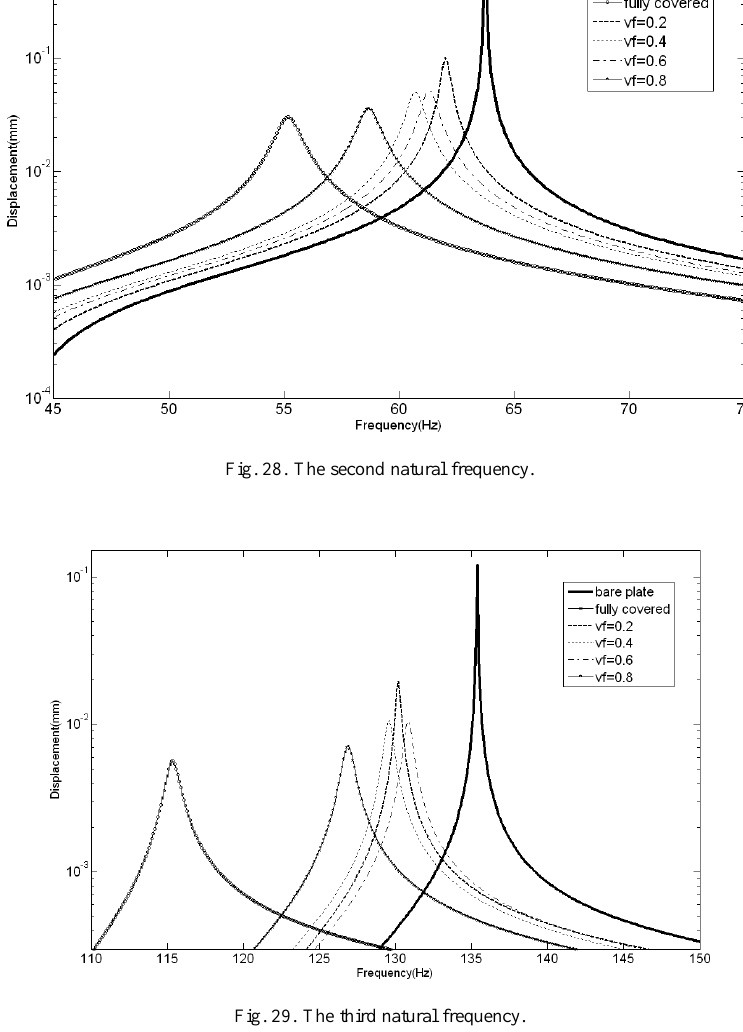
Fig. 29. The third natural